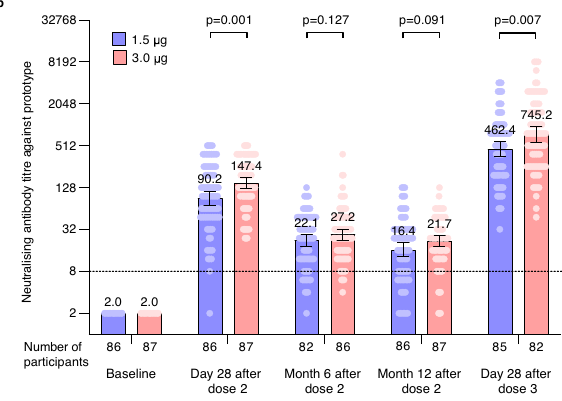
Fig.2|LevelsofneutralisingantibodyagainsttheprototypeSARS-COV-2after immunogenicityassessment.a Neutralisingantibodytitresagainsttheprototype SARS-COV-2inCohort1. b NeutralisingantibodytitresagainsttheprototypeSARS- COV-2 in Cohort 2. The number of participants for 1.5 μ g group (blue) and 3.0 μ g group(red)ateachvisitincludedintheanalysisisprovidedbelowthebars.Dotsare reciprocal neutralising antibody titres for individuals in the per-protocol popula- tion. Numbers above the bars are GMTs, and the error bars indicate the 95%CI.